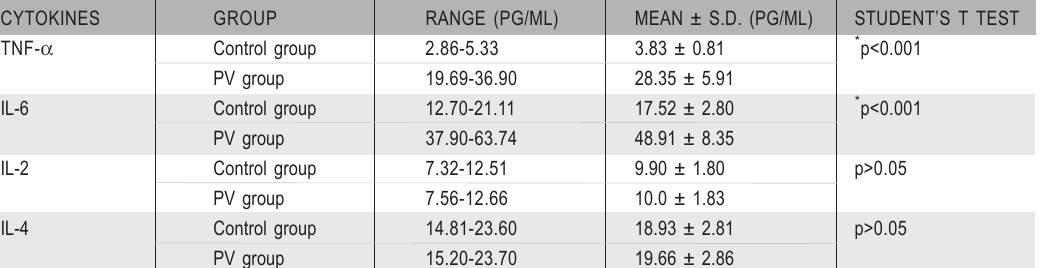
Table 1: Cytokines levels in the sera of patients with Pemphigus vulgaris (PV) (n=10) and healthy controls (n=10).